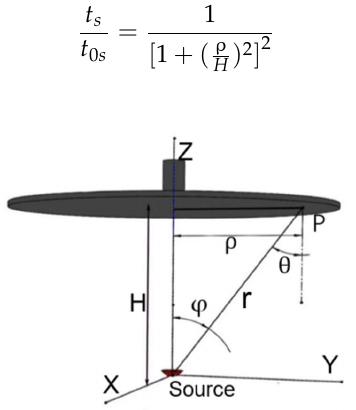
( b ) Figure 5. ( a ) Racetrack shape in rectangular sputtering target; ( b ) racetrack in circle shaped target. Thin film thickness with different types of sources is summarized in Table 2: Table 2. Thin film thickness distributions for different types of sources. Source Types Thickness Distribution Evaporation source